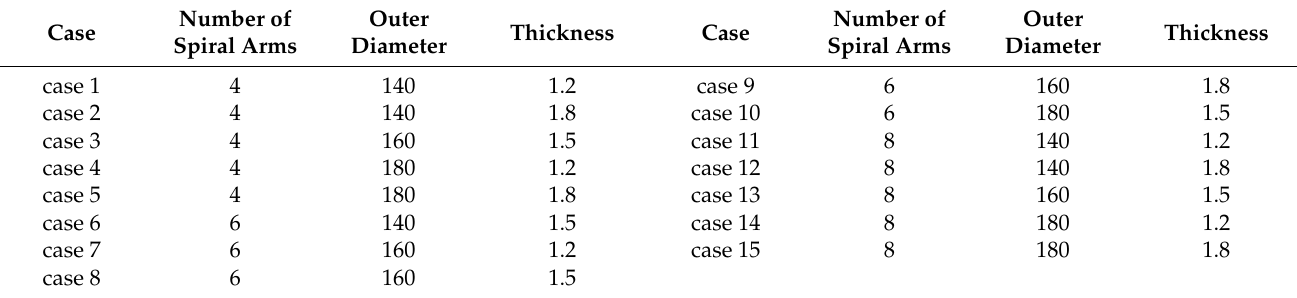
Table 3. Spring design set of central composite design